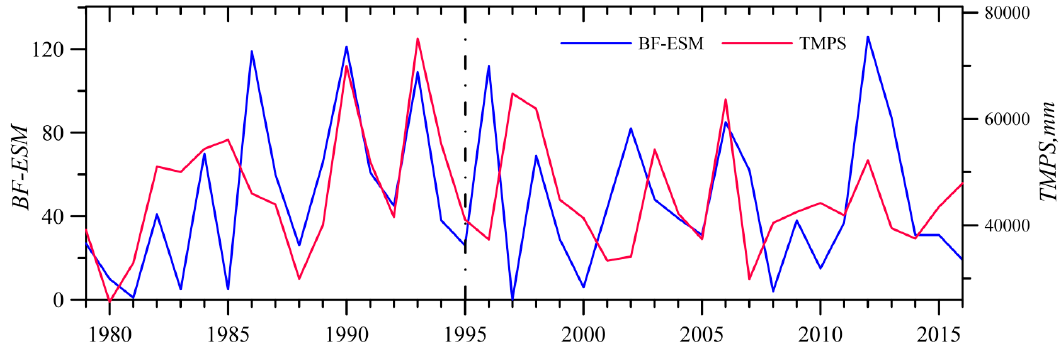
Figure 4. Interannual changes in the ESM-blocking frequency (ESM-BF) and TMPS . Increased precipitation is observed in response to the increase in blocking frequency.